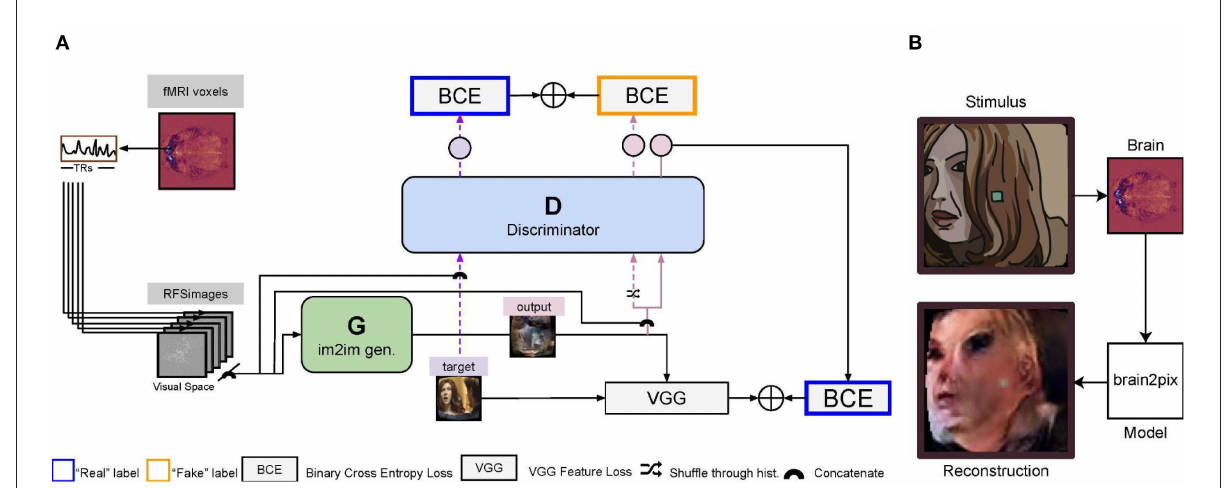
FIGURE1 Illustration of the brain2pix model. (A) First, the voxels of each region of interest (ROI) voxels are extracted. The voxel receptive fields are then projected onto the input (visual) space. Using this mapping, the 2D receptive field signal images (RFSimages) are created, which reflect voxel activity at the locations of their receptive fields in the visual space. To account for the hemodynamic delay, these activities are taken with a fixed delay of 5 TR (i.e., the activities are taken from the volume recorded approximately 4 s after stimulus presentation). The input to the generator are the RFSimages, and the outputs are the reconstruction (end-to-end modeling). The loss is estimated between the target (original) image and this reconstruction as a feature loss (VGG loss). The reconstruction is also passed through the discriminator, concatenated with the RFSimages. The loss for training the discriminator is obtained by summing its output based on the reconstructed image and the target image (concatenated with the RFSimages), using a binary cross entropy (BCE) loss. The BCE loss estimated on the discriminator’s output is summed with the VGG loss, and this sum of losses is then used to backpropagate and update the parameters of the generator. (B) Example reconstruction on the test set. The end-to-end model reconstructs static video frames, using the brain signal of the participant watching Doctor Who in the fMRI scanner as the